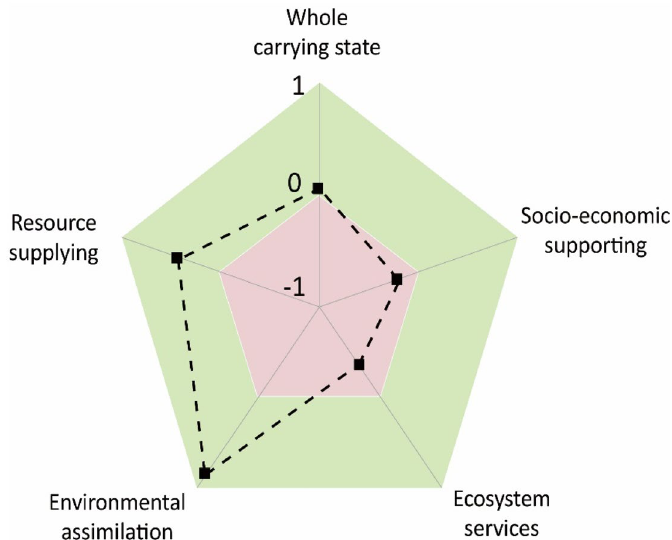
Figure 2. Assessment of CORE-CC (whole carrying state) and its each dimension’s carrying state for ZSI in